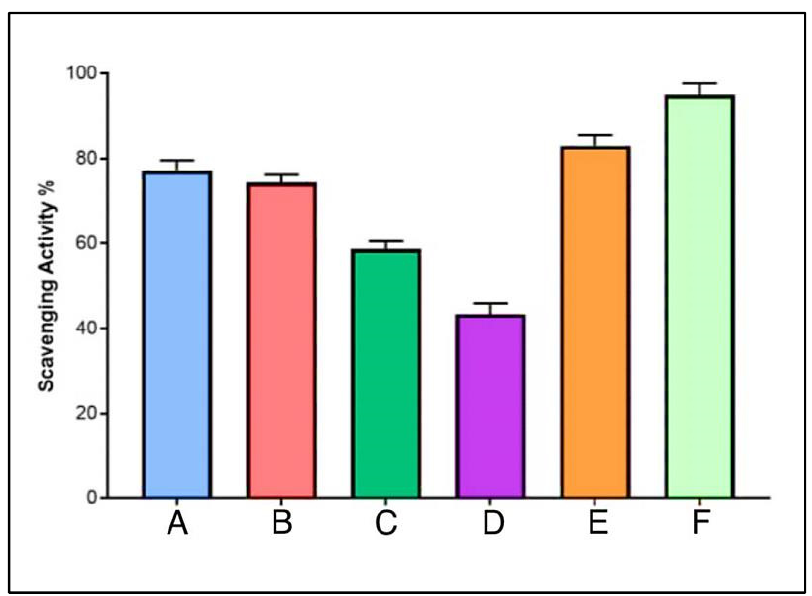
Figure 14. Anti-oxidant potentials of AgNPs at different concentrations (A. 100, B. 50, C. 25, and D. 12.5 μ g /mL), E. AgNPs–lincomycin mixture, and F. ascorbic acid.